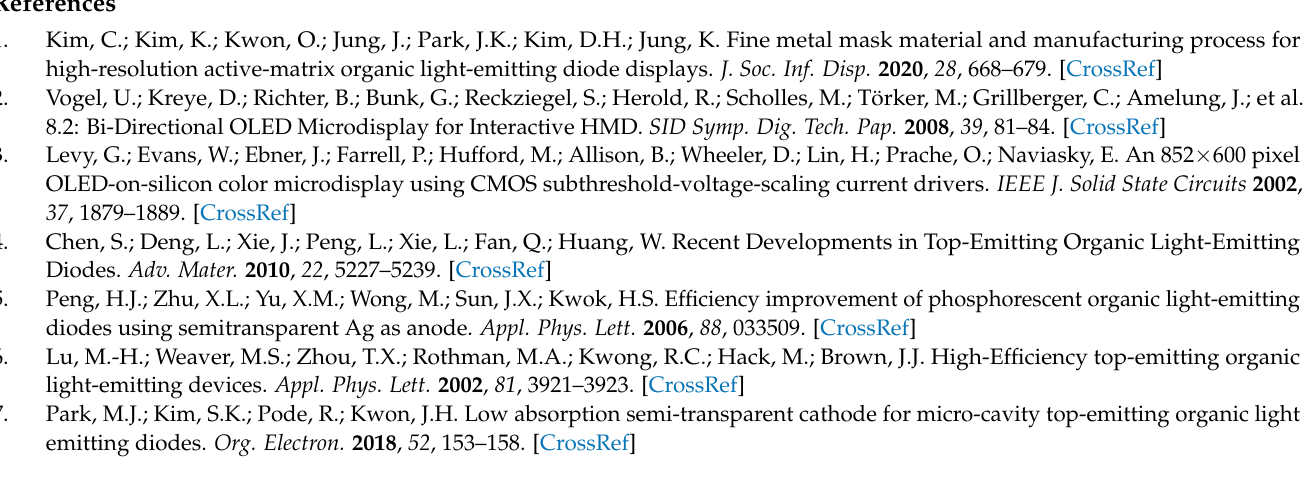
Figure 3. Energy band diagram of the proposed OLED device with Al anode and HATCN